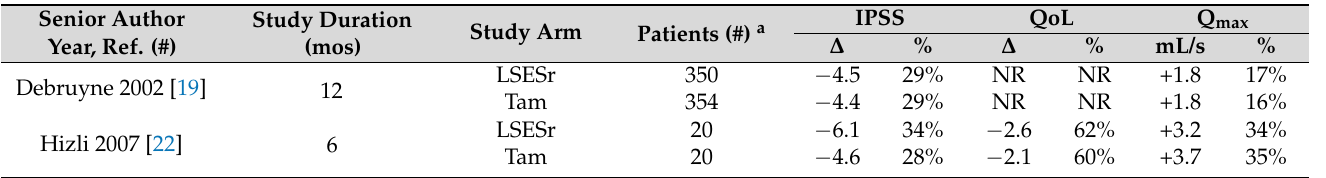
Table 4. Debruyne 2002 and Hizli 2007 clinical evaluation of LSESr vs. tamsulosin (Flomax ® ) at study end. These two clinical trials were cited by AUA 2014 as broadly indicative of the lack of value of “saw palmetto” to ameliorate LUTS, despite essentially identical results with